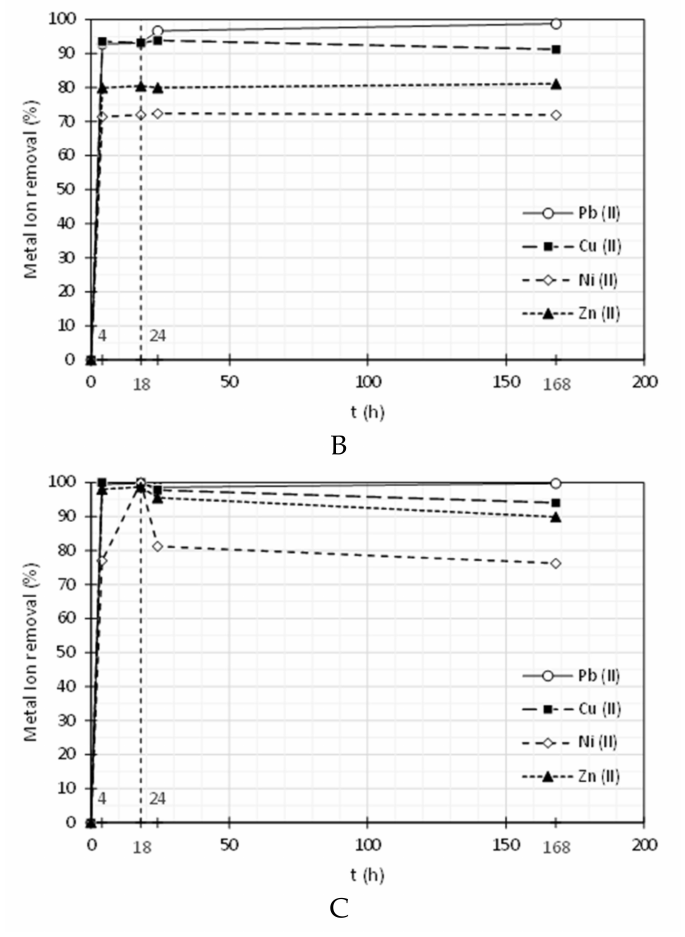
Figure 2. Metal ion removal by suspensions of 0.01% ( w / w ) of MWCNTs dispersed by SDBS ( A ), Pluronic F-127 ( B ) and polyDADMAC MMW ( C ). All surfactants concentrations were equal to 0.03% ( w / w ). Table 3. Removal of Pb (II), Cu (II), Ni (II) and Zn (II) by a suspension of 0.01% ( w / w ) of MWCNTs in a solution of 0.03% ( w / w ) of